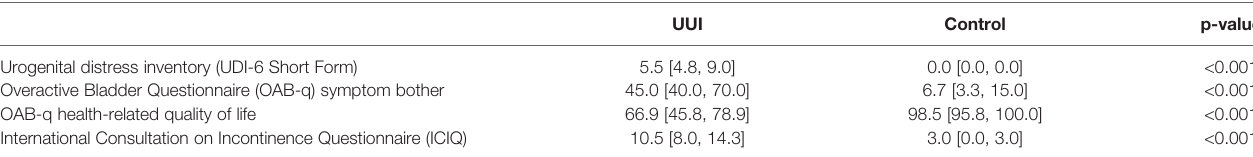
TABLE 2 | Participant bladder